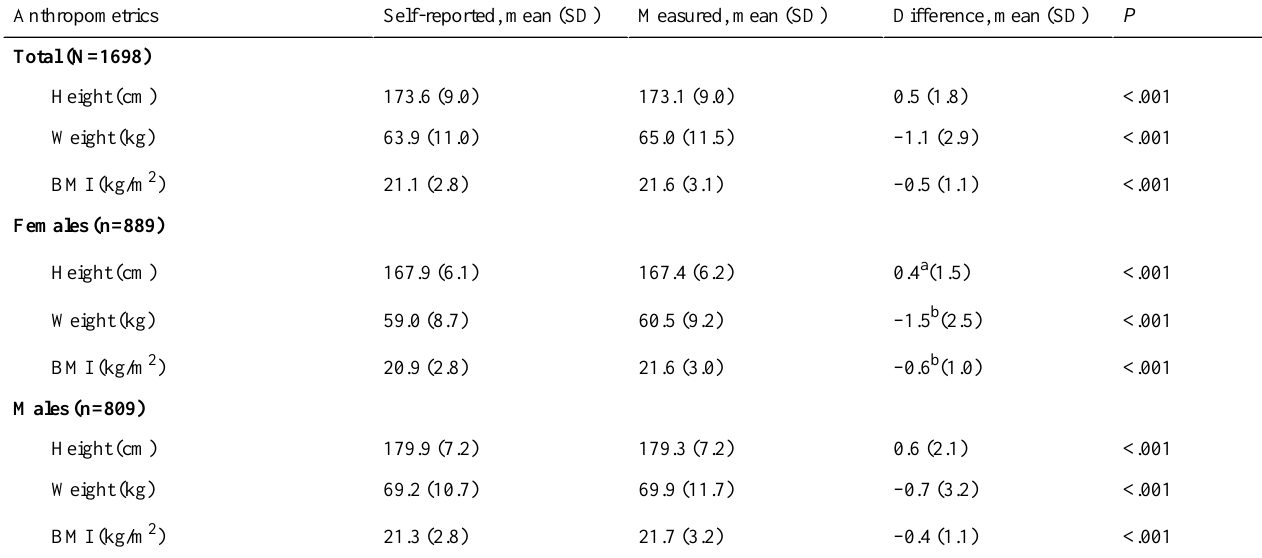
Table 2. Mean self-reported and measured height, weight, and BMI by